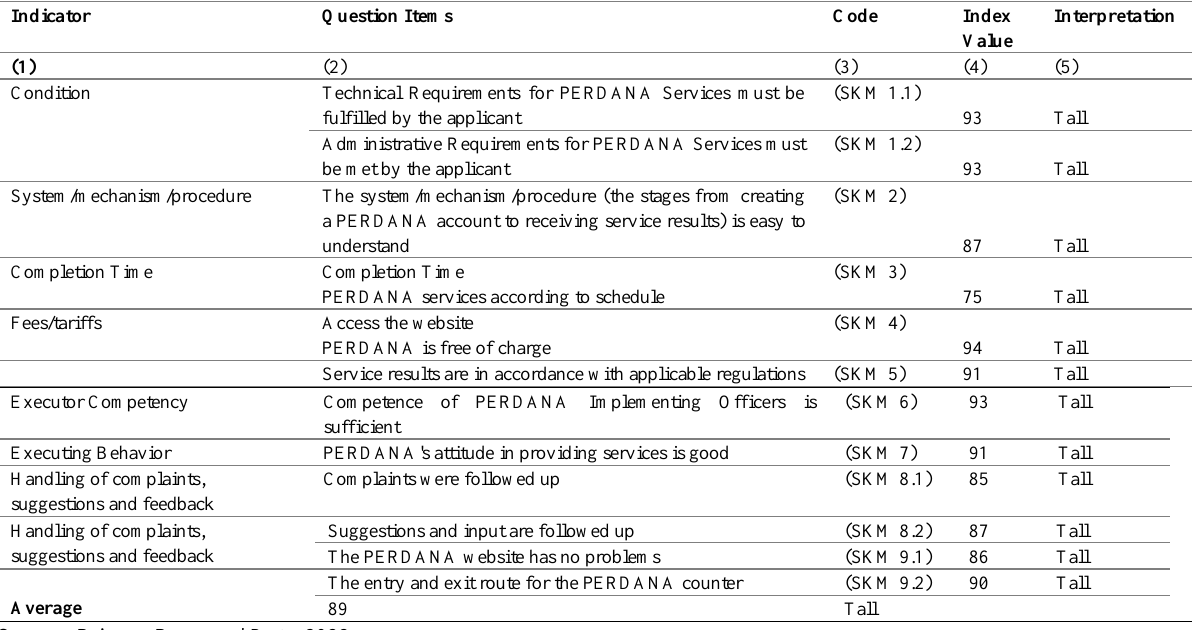
Table 6: Index Value and Variable Interpretation of Community Satisfaction Survey on the PERDANA at the Land Office of Pontianak